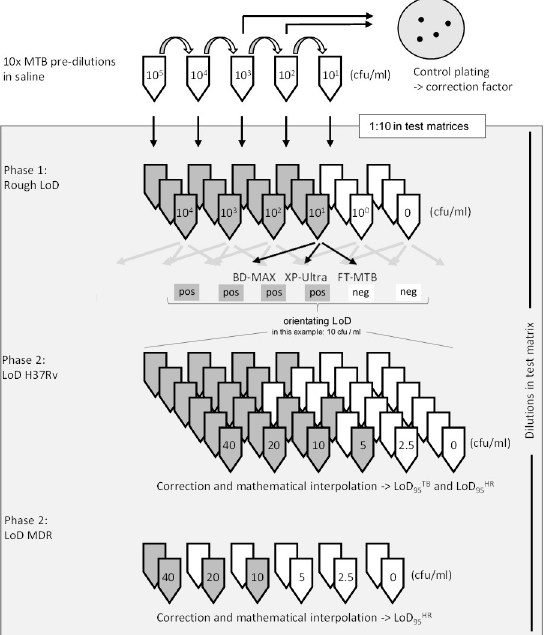
Fig 1. Schematic overview of LoD 95 experiments. 10x pre-dilutions of H37Rv and an MDR MTBC isolate were prepared and spiked in human sputum, MUCAS or saline solution. In phase 1 three 10-fold dilution series (10 4 to 0 cfu/ml) were produced in all test matrices. The orienting LoD was determined for each matrix/test combination (in the example, 10 0 negative & 10 1 positive = > LoD 10 cfu/ml). In phase 2 the LoD 95TB / HR were determined using at least six 2-fold dilutions per matrix/test around the respective orienting LoDs. Calculated LoD values were corrected according to colony counts of plates and interpolated using GraphPad Prism 8.0.2 to yield the 95% LoD and the 95%- CIs (GraphPad Software,